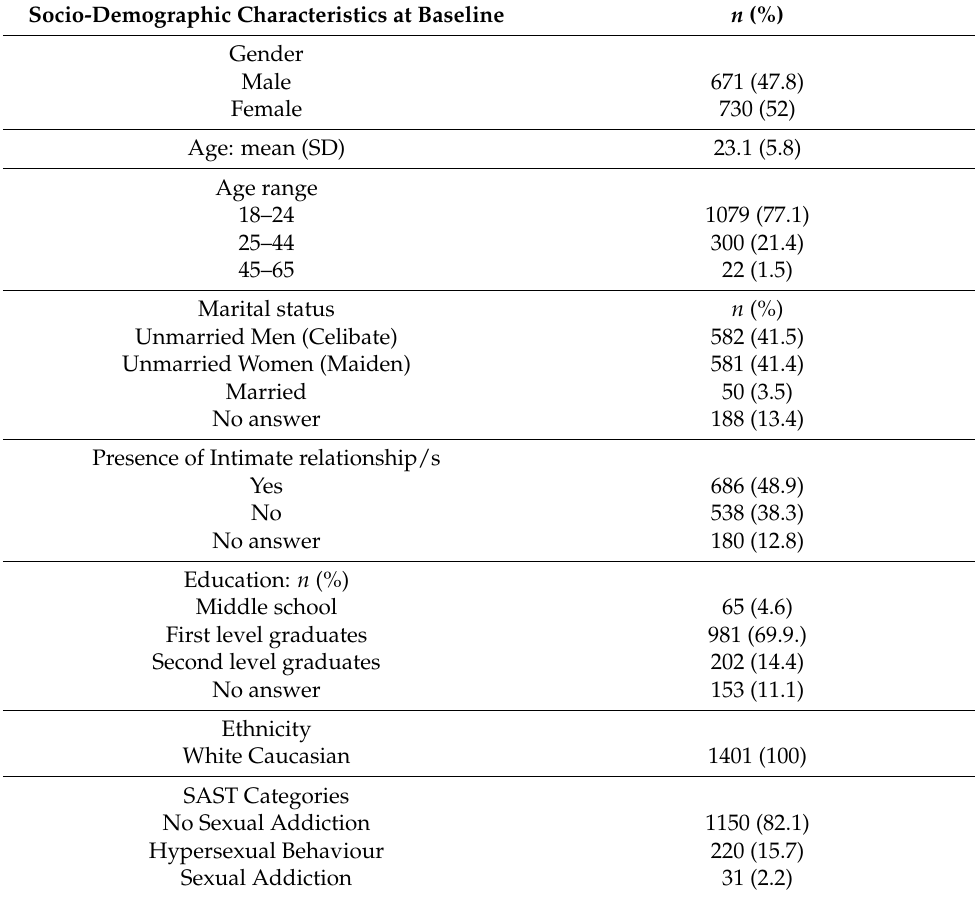
Table 1. Participants’